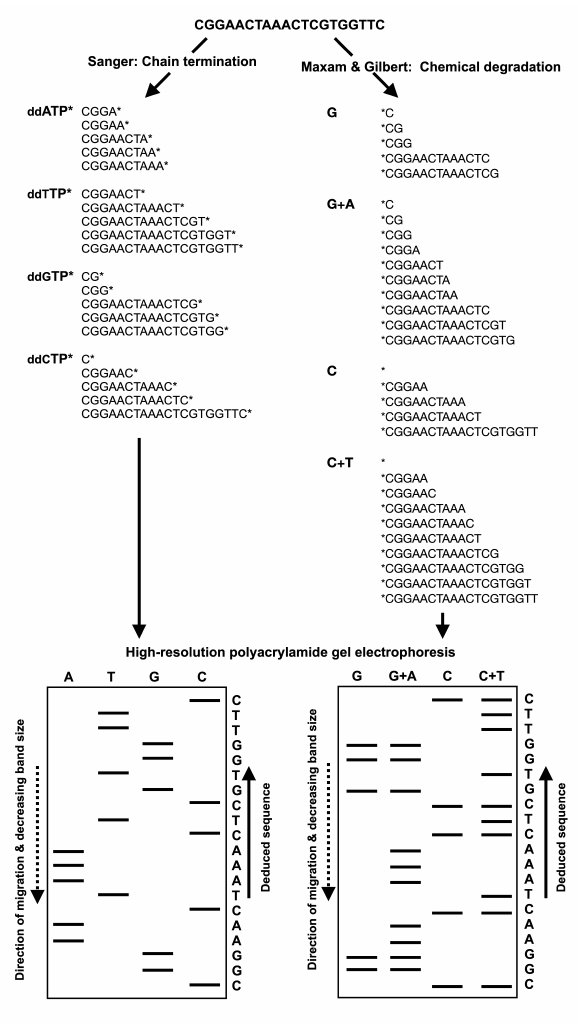
Figure 1. Schematic illustrations of Sanger’s chain-termination and Maxam and Gilbert’s chemical sequencing techniques. In Sanger’s sequencing method, radiolabeled ddNTP nucleotides of a specific type (i.e., ddATP, ddTTP, ddGTP and ddCTP) are included in the DNA polymerase reactions at low concentrations along with the dNTPs. In each of the four reactions, polymerization will continue to extendwithdNTPsuntiladdNTPisincorporated, generatingDNAstrandsofvaryinglengths. TheDNA fragments are then visualized by high-resolution polyacrylamide gel electrophoresis. The nucleotide sequence is then deduced by finding the lane in which the band is present for a given site, as the 3 (cid:48) terminating labeled ddNTP corresponds to the base at that position. Maxam and Gilbert’s method requires the radiolabeling ( 32 P) of the 5 (cid:48) phosphate moiety of the DNA fragment to be sequenced prior to chemical treatment for the selective removal of the base from a small proportion of the DNA molecules. Guanine is methylated by dimethyl sulfate, formic acid depurinates the purines (adenine and guanine); hydrazine hydrolyzes the pyrimidines (cytosine and thymine) and hydrazine in the presence of high salt (sodium chloride) concentrations can only react with cytosine. Piperidine is then used to cleave the phosphodiester backbone at the position of the modified base, yielding fragments of various lengths. The DNA fragments are then separated by high-resolution polyacrylamide gel electrophoresis in order to deduce the nucleotide sequence. The guanine (G) bands are present in both the G and A + G (purine) lanes, while the adenosine (A) band is present only in A + G lane. Similarly, cytosine (C) is indicated by the presence of bands in both the C and C + T (pyrimidines) lanes, while thymidine (T) bands are present only in C + T